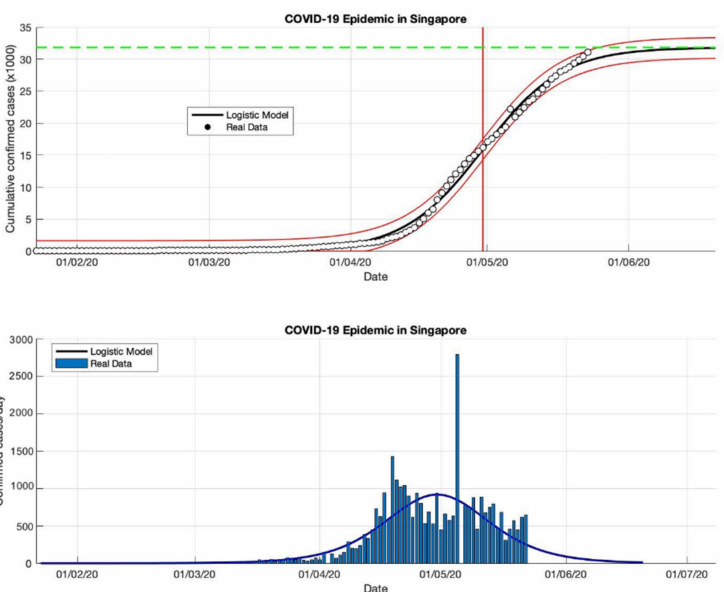
Figure 4. In the above figure, the prediction results of the logistic growth model for cumulative infected cases are compared with the actual data, while the two red lines between the black lines represent a prediction error limit of about 5%. The dashed green line predicts the total size of infected cases in the final phase of the epidemic. The red line intersects the cumulative case curve to predict the turning point or peak point of the epidemic (this line is parallel to the top of the curve from the below figure). In the below figure, the prediction results of this model for daily infected cases in